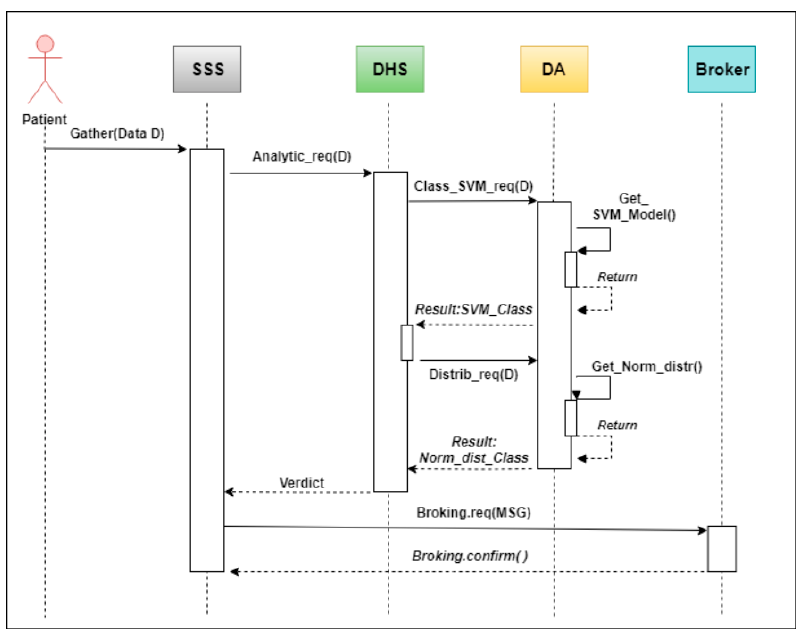
Figure 8. Interaction diagram of the alerts broking process .